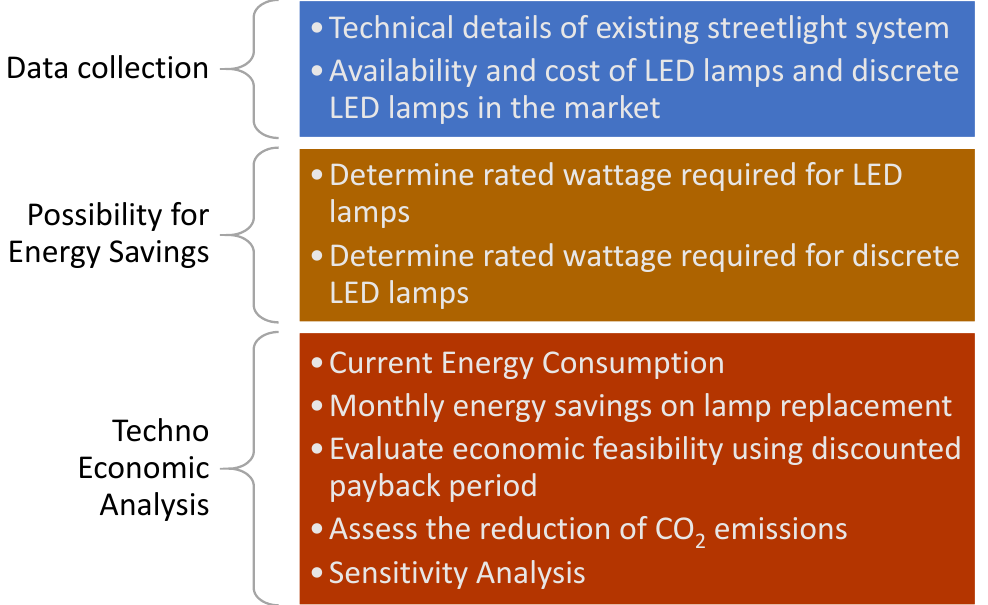
Energies 2021 , 14 , x FOR PEER REVIEW Figure 1. Steps involved in the techno economic analysis of replacing HPS lamps with LED and discrete LED lamps.